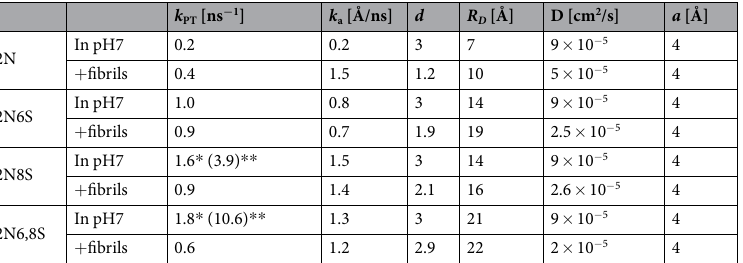
Table 1. SSDP fits to the decay of the photoacids before and after the binding to the insulin fibril structure. * These values are underestimated due to the slow light source, see further discussion in the text. ** These values are the fast component of a re-convolution of the IRF signal with a 3-exponential decay fit, see further discussion in the text and Figure S3.